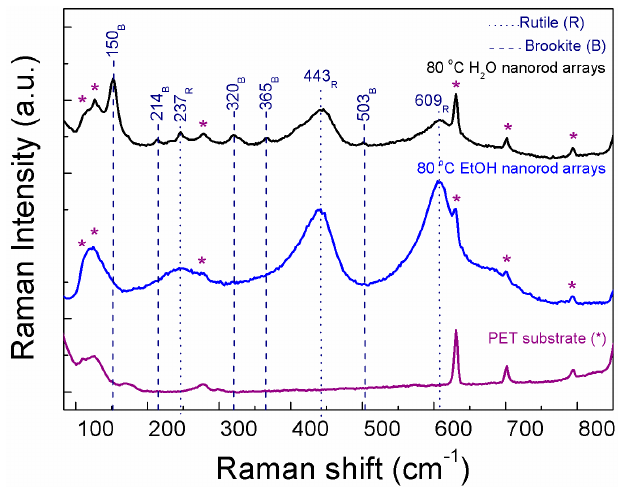
Figure 2. Raman spectra of the TiO 2 nanorod arrays produced with water and ethanol at 80 °C, together with the PET substrate for comparison. Dot lines indicate the rutile bands and dashed ones point out to the brookite ones.